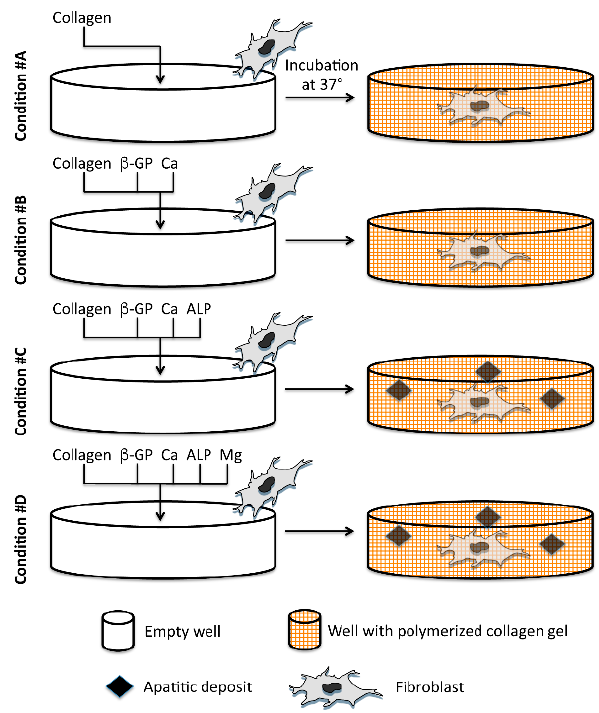
Figure 1. Experimental protocol for collagen gel preparation. Condition #A is represented by a standard collagen gel and, in sequence, the following components are added: β -glycerophosphate ( β -GP) and CaCl 2 (Ca) (condition #B ), Alkaline Phosphatase (ALP) (condition #C ) and MgCl 2 (Mg) (condition #D ). Presence of ALP in #C and #D promotes the cleavage of β -GP to release phosphate that can react with calcium ions to form apatitic deposits. In all experimental conditions, fibroblasts are added before collagen gel polymerization.